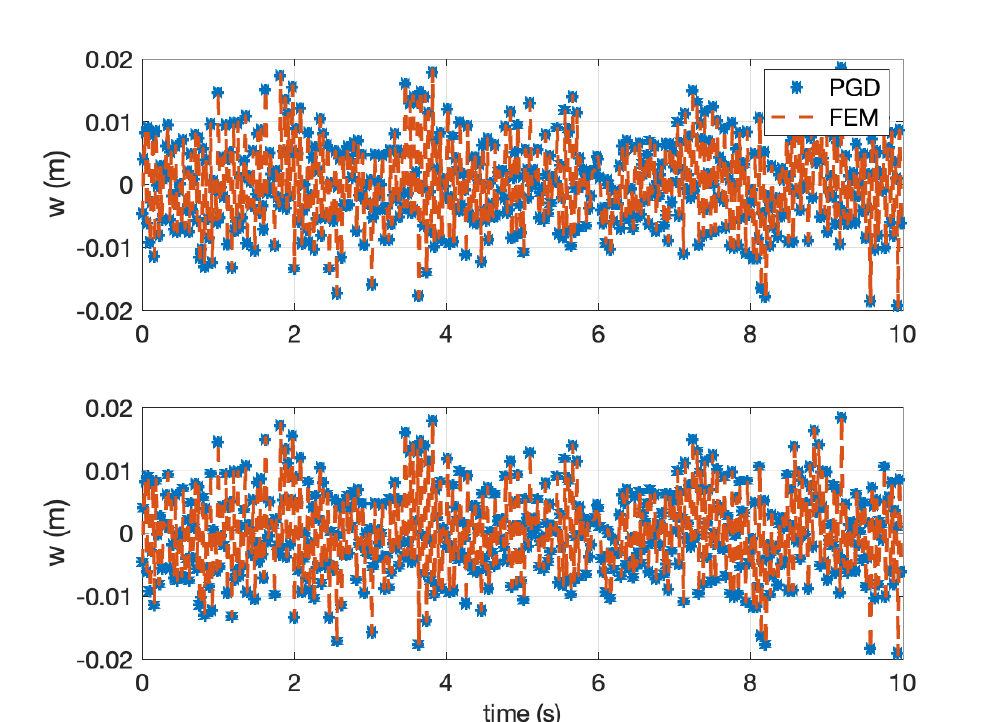
Figure 8. z-component of the displacement at the top of both layers: (top) top layer and (bottom) bottom layer.